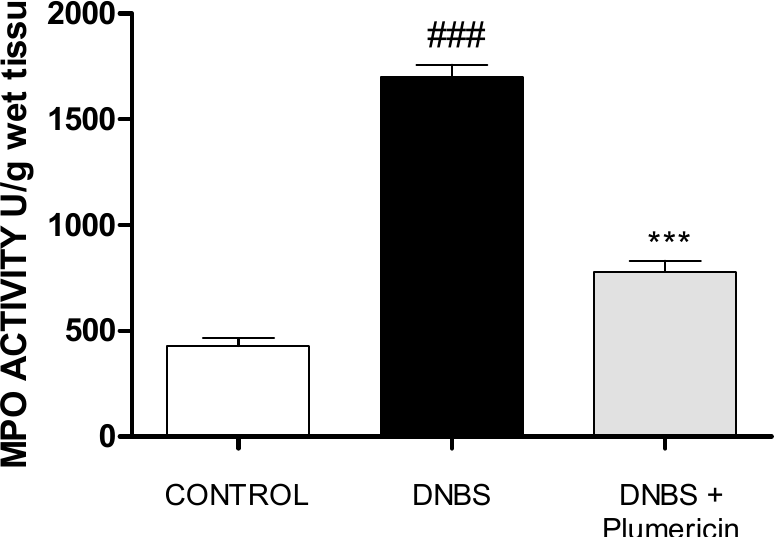
Figure 6. Effect of plumericin on myeloperoxidase (MPO) activity. Data are expressed as the mean ± S.E.M. of 10 mice for each group. ### denotes p < 0.001 vs. control group; *** denotes p < 0.001 vs. DNBS.